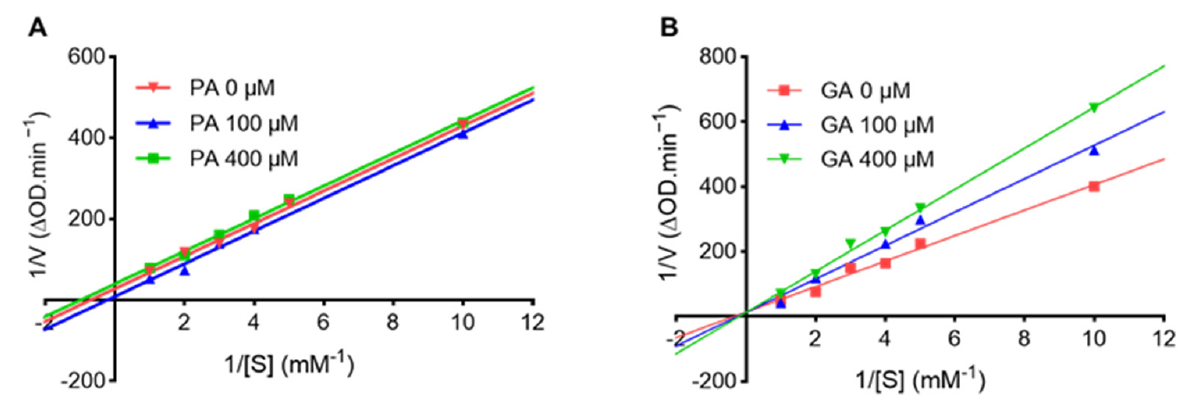
Figure 3. Lineweaver–Burk plots of FALGPA hydrolysis by collagenase in the presence of PA ( A ) and GA ( B ). Michaelis–Menten parameters for collagenase hydrolysis of FALGPA in the presence of PA or GA at concentrations of 100 µ M and 400 µ M. Table 2. Michaelis–Menten kinetic parameters for collagenase-catalyzed hydrolysis of FALGPA in the presence of PA and GA at concentrations of 100 and 400 µ M. Km Concentration Compound ( µ M) (mM) Uncompetitive100